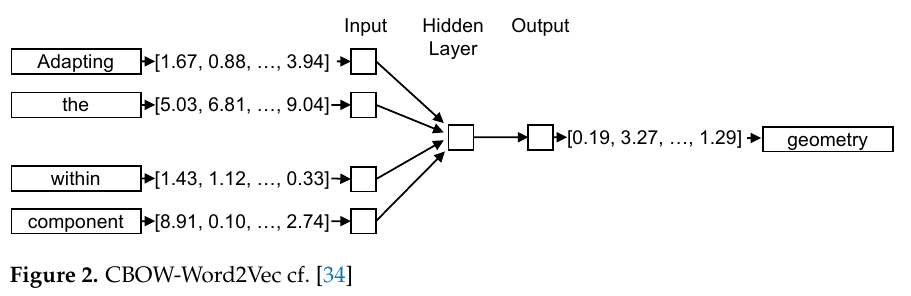
Figure 2. CBOW-Word2Vec cf. [34]